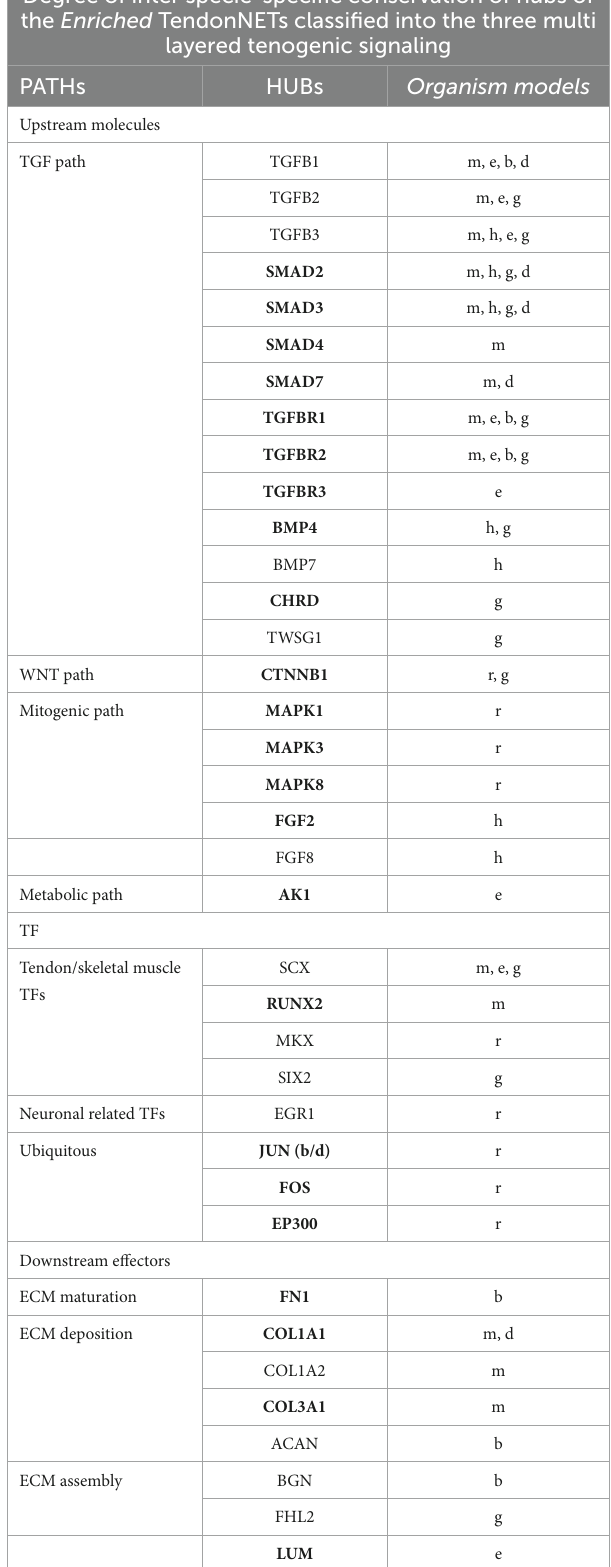
Data reported in this table derived from the application of the Venn diagram and stratification analyses to the hubs of the Enriched TendonNETs. The 24 new hubs derived after STRING enrichment are reported in bold. The different colors of the hub molecules allow to identify the signaling layer of pertinence. In orange were reported nodes of the upstream layer, in green nodes of the TF layer, and in light blue nodes of the downstream